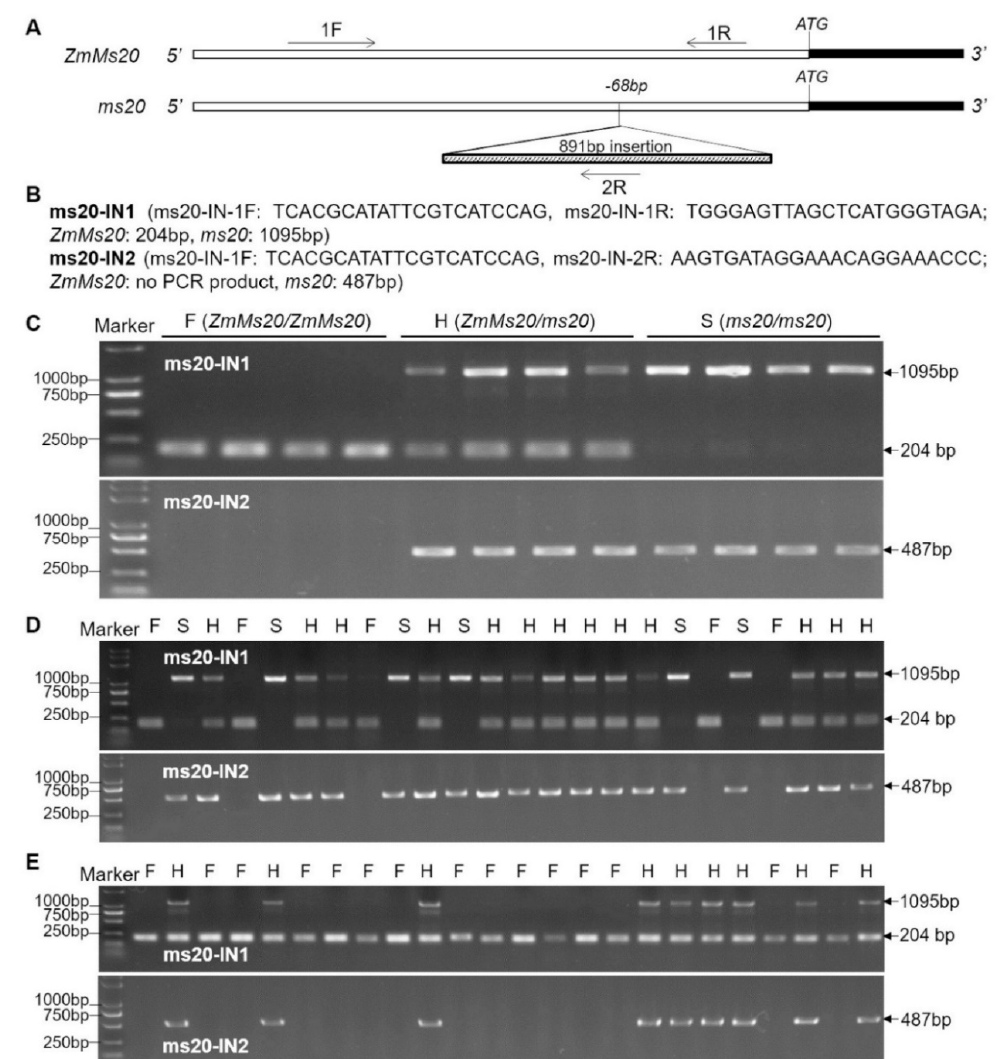
Figure 6. The functional markers of ZmMs20 / ms20 and MAS of ms20 mutant locus to introduce it